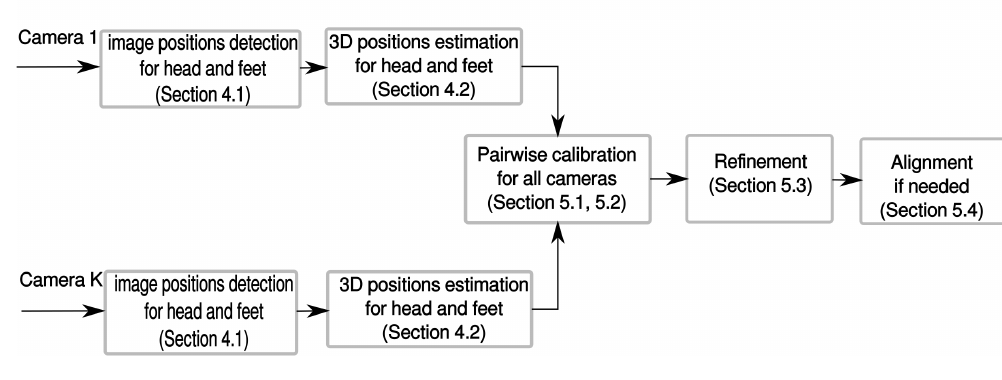
Figure 1. Architecture of the proposed calibration method.